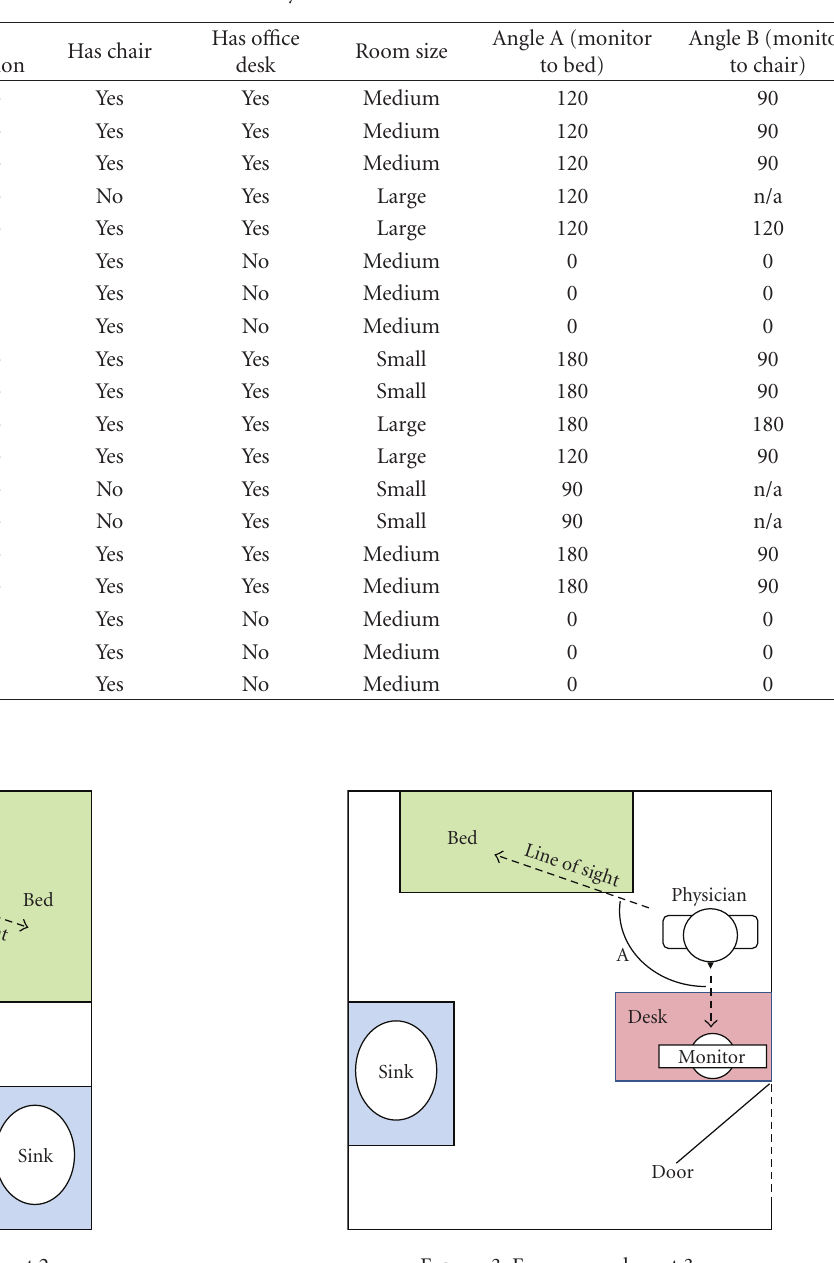
Table 3: Exam room layout results.